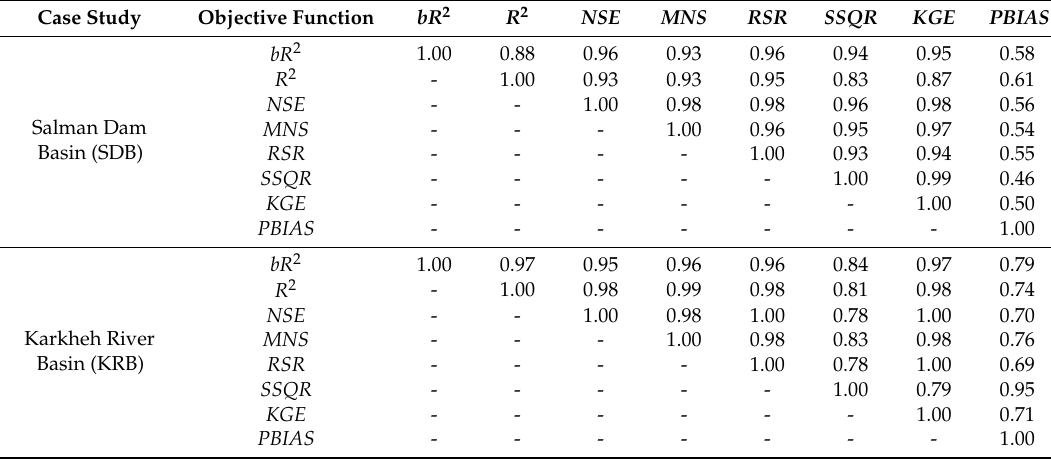
Table 6. Correlation coefficients of the objective functions based on the best simulation in the calibration period using the SUFI-2 algorithm.